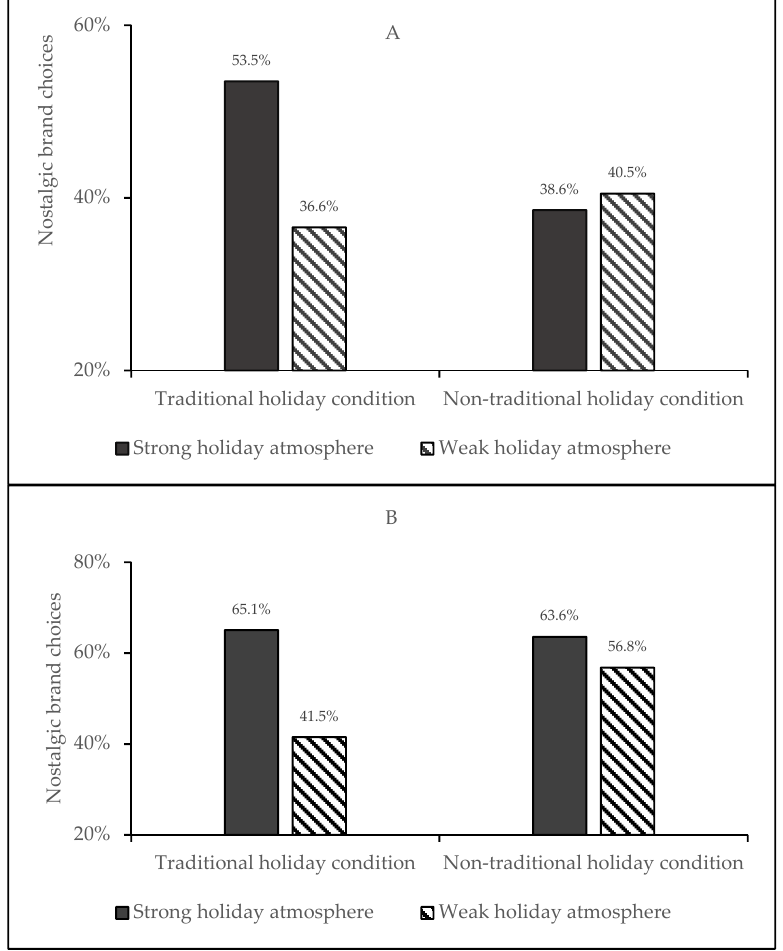
Figure 5. Moderation effect of holiday type (traditional vs. non-traditional). ( A ) Food brands. ( B ) Hand cream brands.